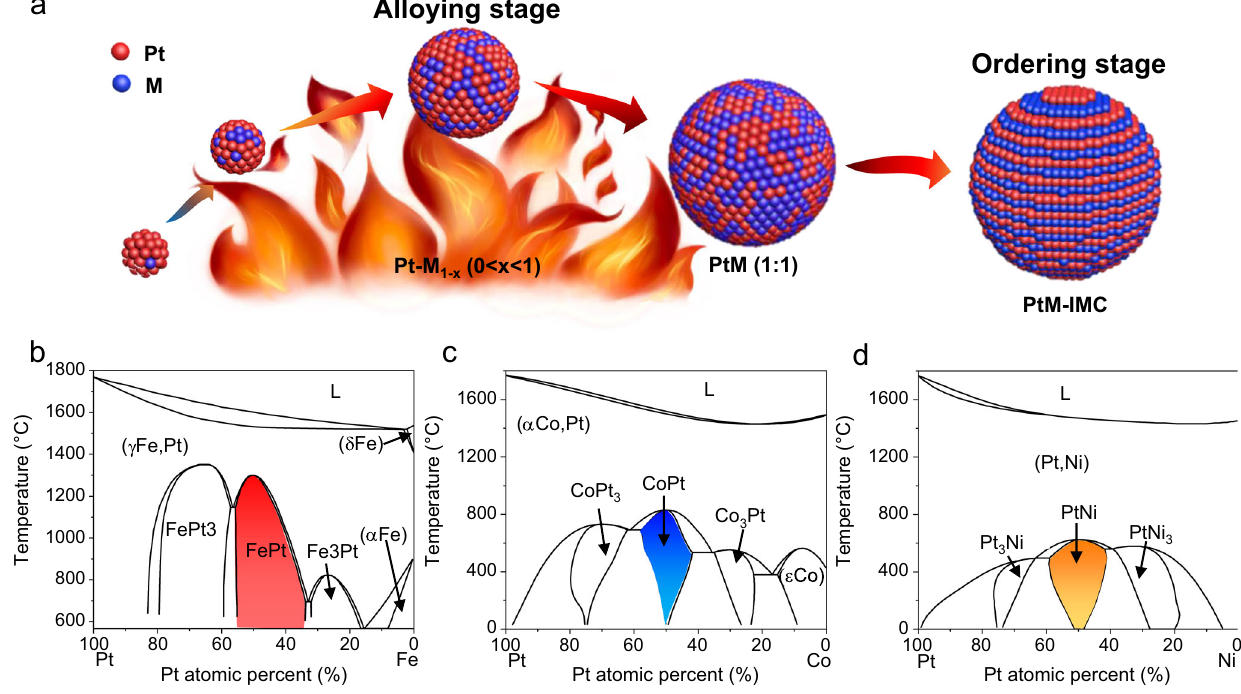
Fig. 1 | Schematic illustration and binary phase diagrams. a Schematic illustra- tionof thesynthesisofstructurallyorderedPt – M(M=Fe,Co,andNi)intermetallic compounds (IMCs), indicating the separate alloying and ordering stages.